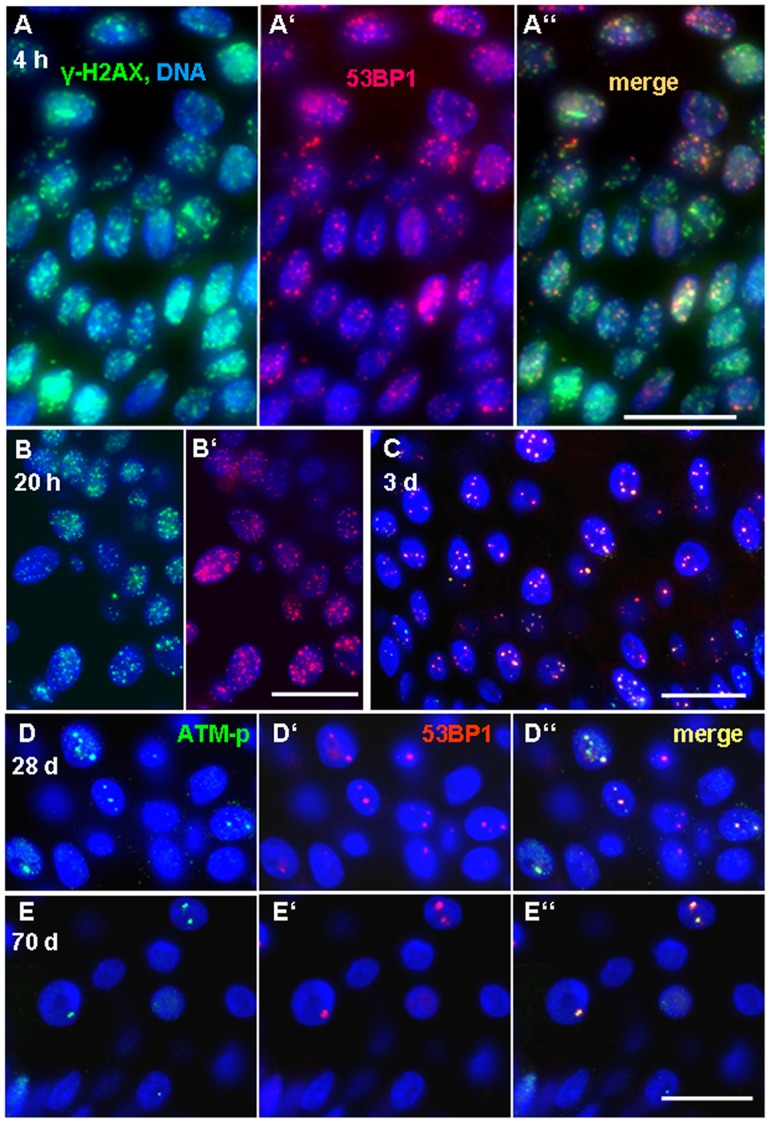
Evolution of DNA damage-dependent γ-H2AX (green) and 53BP1 (red) focus formation as analyzed by immunofluorescence and 3D maximum image projection.(A-A’’) Skin section displaying strong patchy γ-H2AX and spotty 53BP1 fluorescence 4 h after 50 Gy irradiation. Separated green (A) and red (A’) channels, as well as RGB merge (A’’) are shown. Numerous nuclei contain large γ-H2AX patches and diffuse labeling, but a fraction of nuclei reveals countable foci. (B) Numerous distinct γ-H2AX and 53BP1 RIF/nucleus are seen in a skin sample 20 h after ex vivo irradiation with 50 Gy in the corresponding green and read (B’) channel images. (C) Skin biopsy 3 days after in vivo IR displaying a lower number of RIF/nucleus indicative of progression of DNA repair. RGB image, the yellowish color at RIFs reflects γ-H2AX and 53BP1 colocalization. (D-E) Damage persistence and ongoing DDR as revealed by active ATM-p (green) and 53BP1 (red) colocalization at large RIFs of keratinocytes 28 days (D-D’’) and 70 days (E-E’’) post IR. Nuclear DNA is labeled in blue (DAPI). Magnification bar: 20 µm.